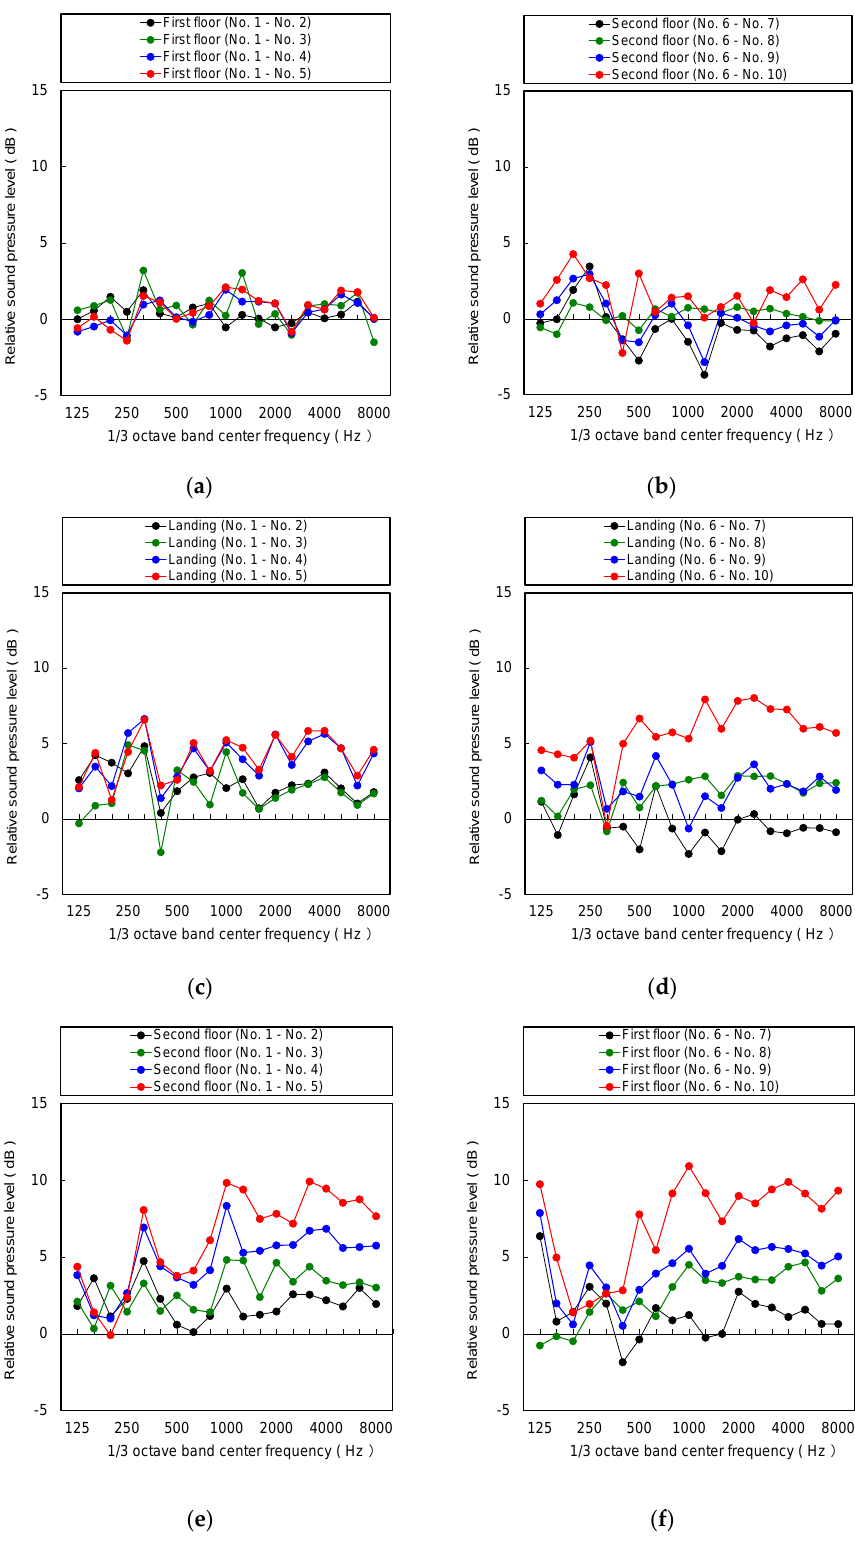
Figure 8. Effect on sound pressure level of the sound absorption panel installation. ( a ) Sound source